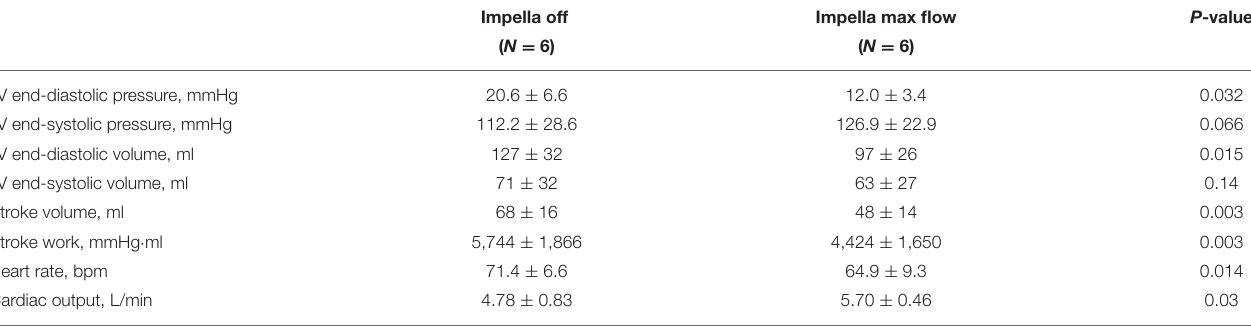
TABLE 2 | Effect of Impella on LV parameters after coronary dissection in animals with large coronary